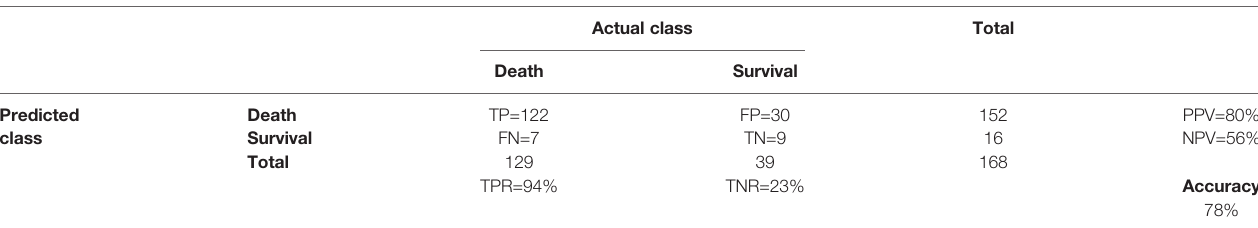
TABLE 2 | Confusion matrix for the model with hemoglobin levels below the median (<13.6 mg/dL).